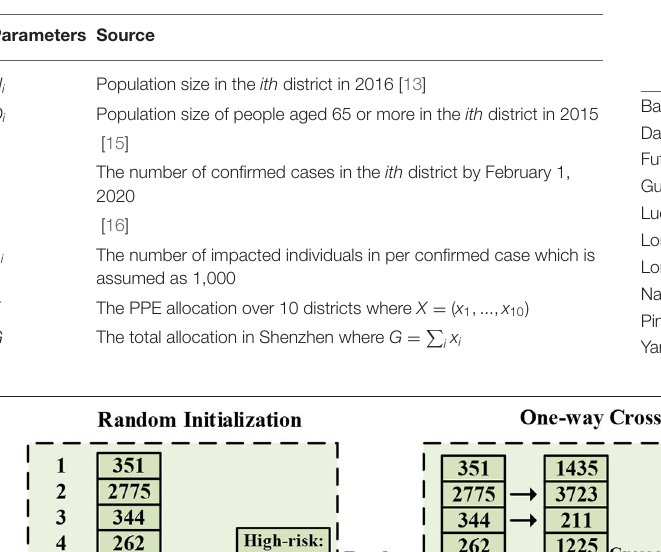
TABLE 1 | Parameters are used in the experiments of the GA-PSO algorithm.